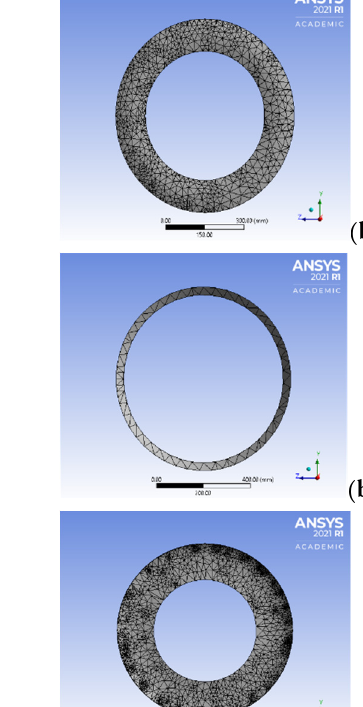
Figure 5. Finite element model of D39200 locomotive wheel.